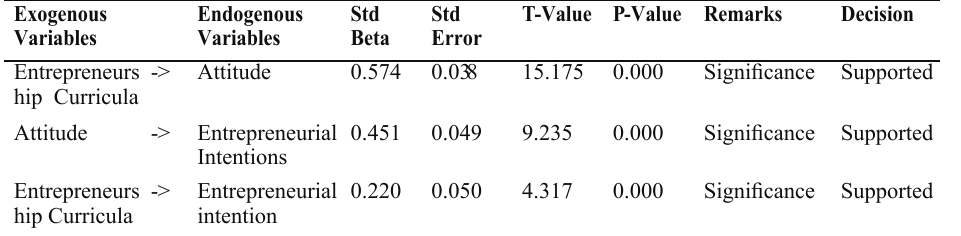
Path Co-efficient Analysis